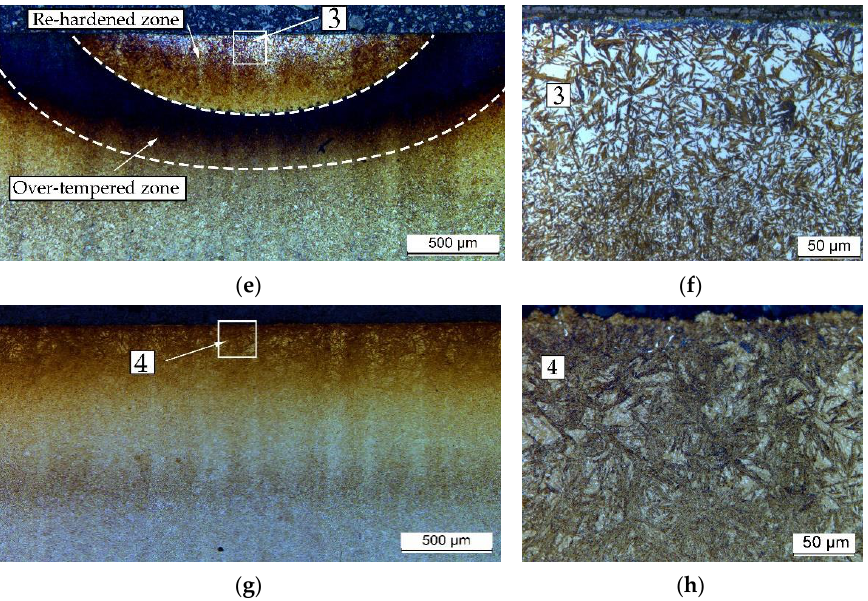
Figure 5. Microstructure of cross-section of tracks created by laser surface heating of the AISI 9310 carburized case-hardened steel: ( a , b ) track 1; ( c , d ) track 2; ( e , f ) track 3; compared to the carburized case ( g , h ) prior to the laser heating.